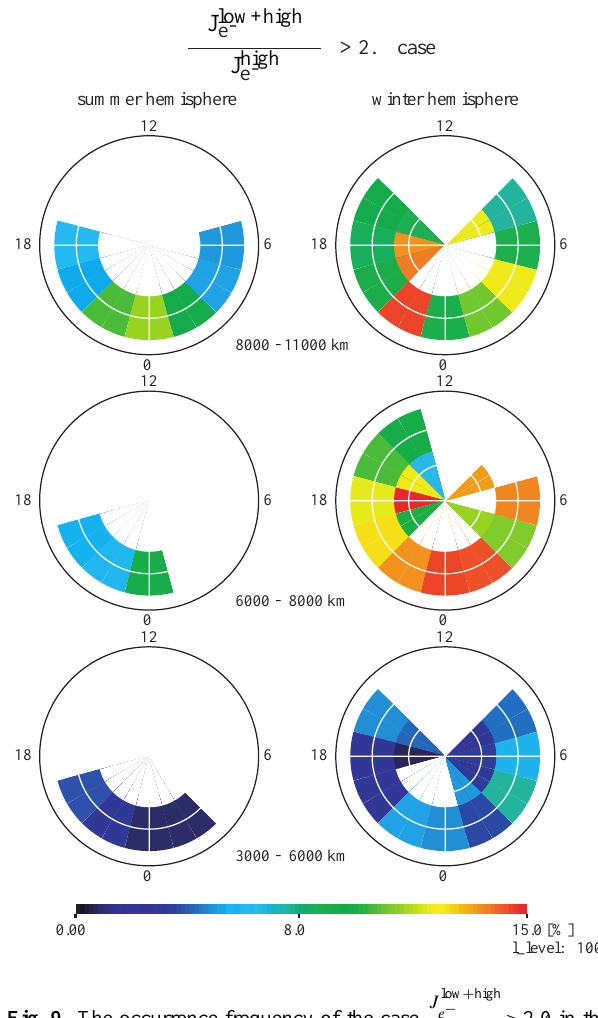
Fig. 9. The occurrence frequency of the case particle acceleration region. The color bar shows the linear defini- tion of the occurrence with maximum value as 15%.